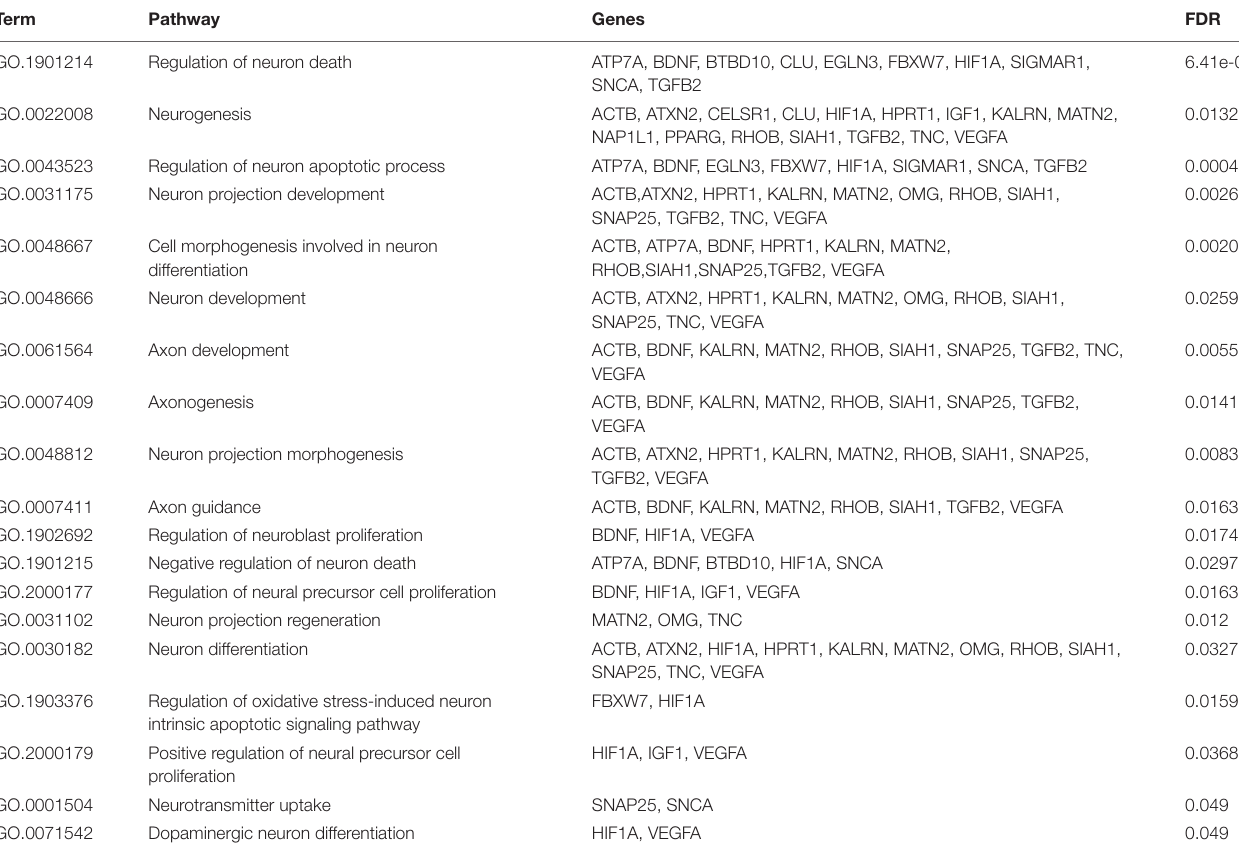
TABLE 1 | Functional and pathway analyses of the genes in the network. Term